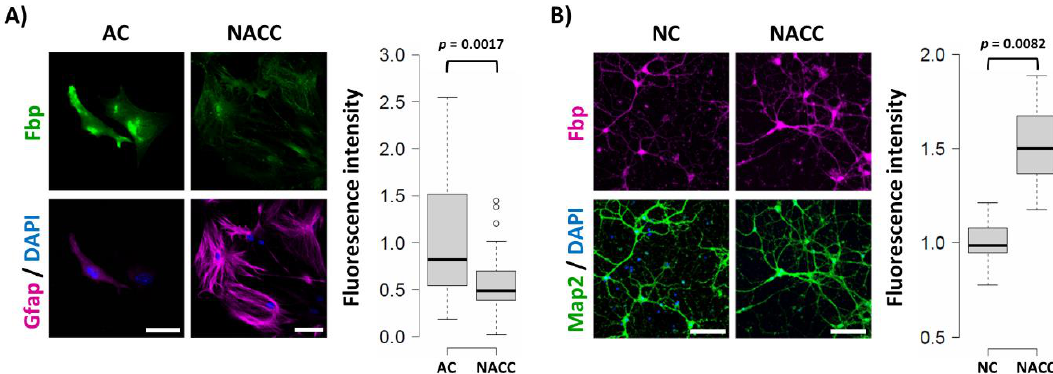
Figure 1. Co-culture-induced changes in the muscle isozyme of fructose 1,6-bisphosphatase (Fbp2) protein-related fluorescence in astrocytes and neurons. ( A ) Co-culturing of neurons and astrocytes (NACC) reduces the Fbp2 protein level in astrocytes (identified by glial fibrillary acidic protein (Gfap) staining) but ( B ) increases it in neurons (identified by microtubule-associated protein 2 (Map2) staining), compared to monocultures of these cells (AC—astrocytic culture; NC—neuronal culture). Box plots present the quantification of the Fbp-related fluorescent signal normalized to control group. Each experiment was repeated at least in triplicate. Bar = 40 µ m in ( A ) and 80 µ m in ( B ).